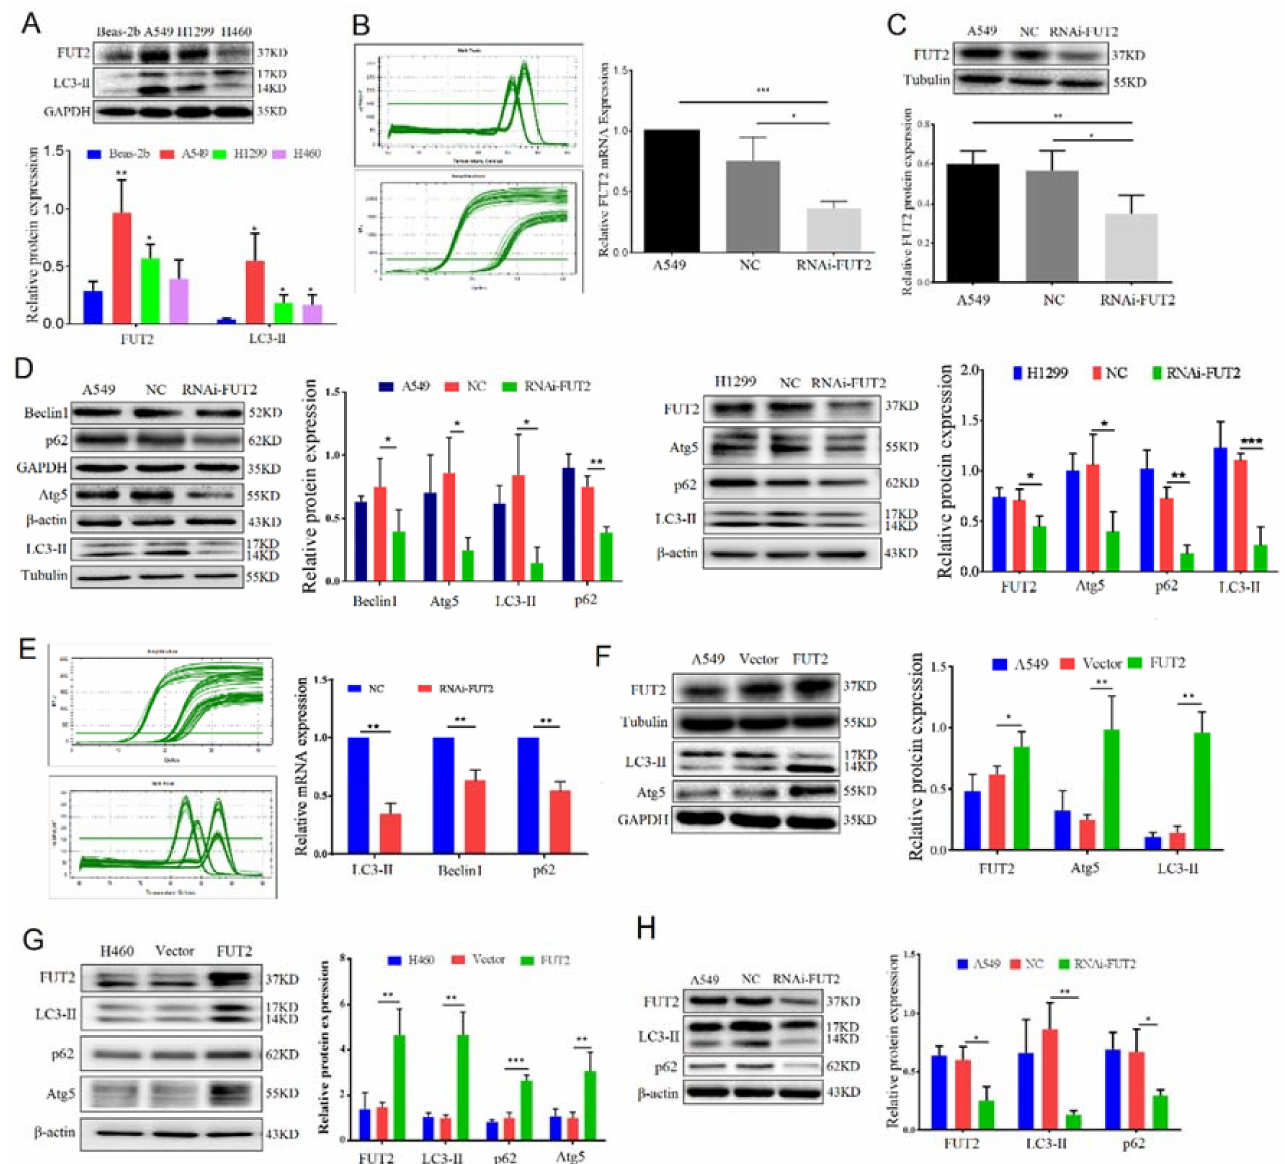
Figure 2. FUT2 promotes the autophagy of lung adenocarcinoma cells. ( A ) Representative Western blot showing the expressions of FUT2 and LC3-II in diverse lung cancer cell lines (A549, H1299, H460) and Beas-2b cells. ( B , C ) Representative RT-qPCR and Western blot showing successful constructions of RNAi-FUT2 A549 cells. ( D ) Representative Western blot showing that knockdown of FUT2 inhibited the expressions of Beclin1, Atg5, p62, and LC3-II in A549 and H1299 cells. ( E ) Representative RT-qPCR showing that the knockdown of FUT2 decreased the mRNA expression of LC3, Beclin1, and p62 in A549 cells. ( F ) Representative Western blot showing that the upregulation of FUT2 expression promoted the expressions of Atg5 and LC3-II in A549 cells. ( G ) Representative Western blot showing that the upregulation of FUT2 expression promoted the expressions of LC3-II, p62, and Atg5 in H460 cells. ( H ) Representative Western blot showing that the knockdown of FUT2 inhibited the expressions of LC3-II and p62 in tumors (* p < 0.05, ** p < 0.01, and *** p <